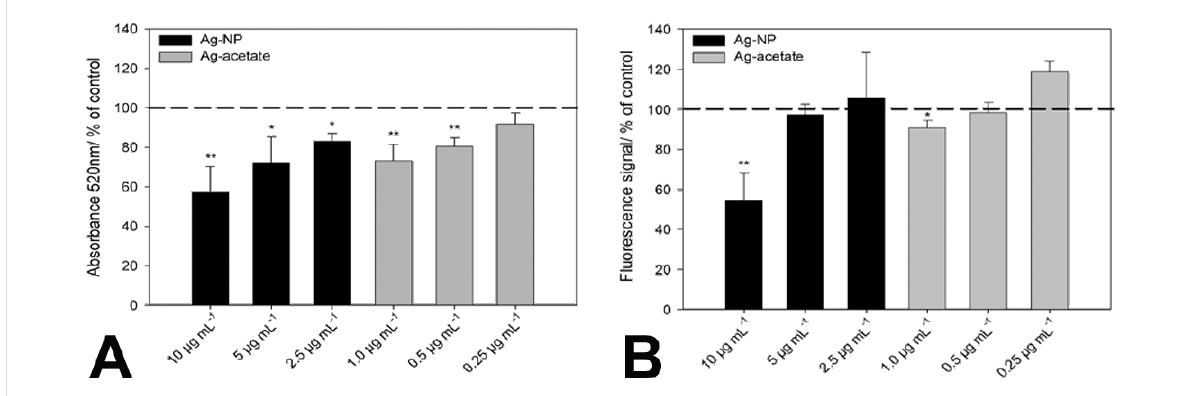
Figure 4: Influence of Ag-NP (black bars) or Ag + ions (grey bars) on the adipogenic differentiation of hMSCs after 14 d of incubation. Quantitative analyses of lipid droplet accumulation were performed by measuring the optical density (520 nm) of extracted oil red-stained lipid droplets (A) or by phase analysis of lipid droplets stained with Bodipy 493/503 (B). The data are expressed as the mean ± SD ( n = 3 independent experiments) given as the percentage of cells cultured under adipogenic conditions in the absence of silver. The asterisks (*) indicate significant differences in comparison to the control (* p < 0.05;** p < 0.005).